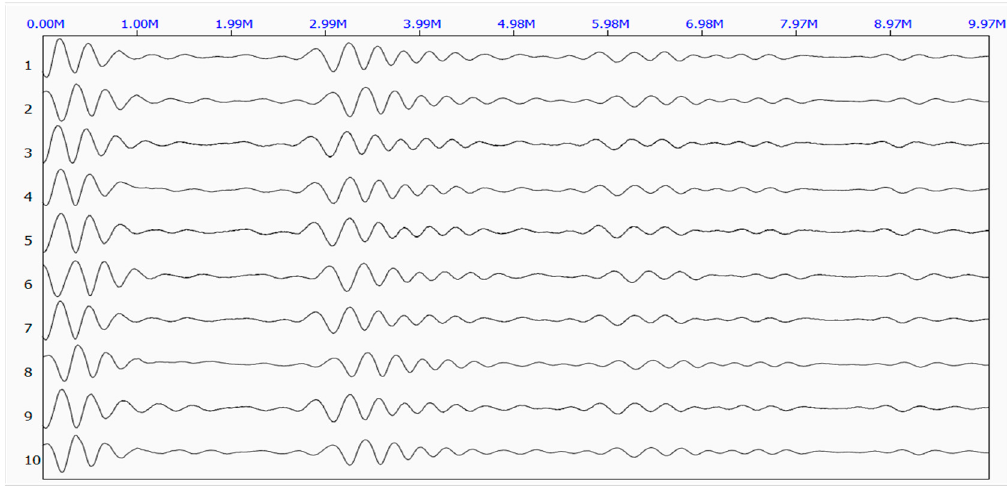
Figure 14. Original waveforms of the reflected stress wave at Site 2.